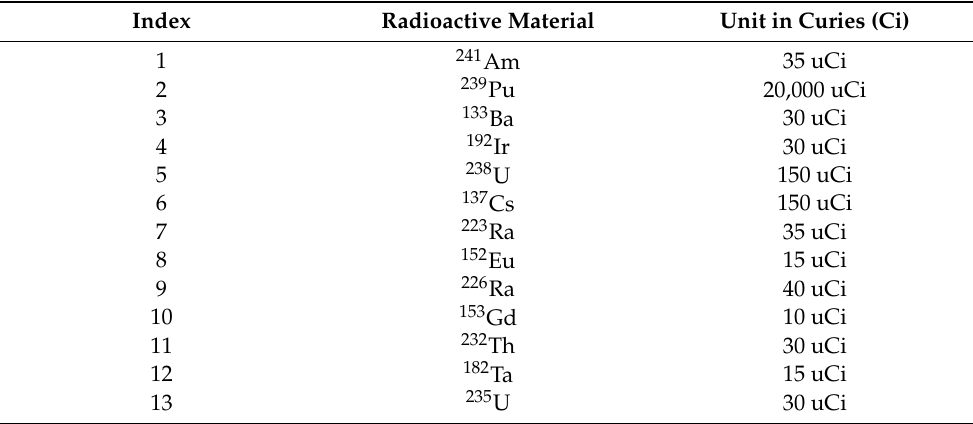
Table 2. Radioactive materials and their activity units used in the GADRAS simulation with NaI